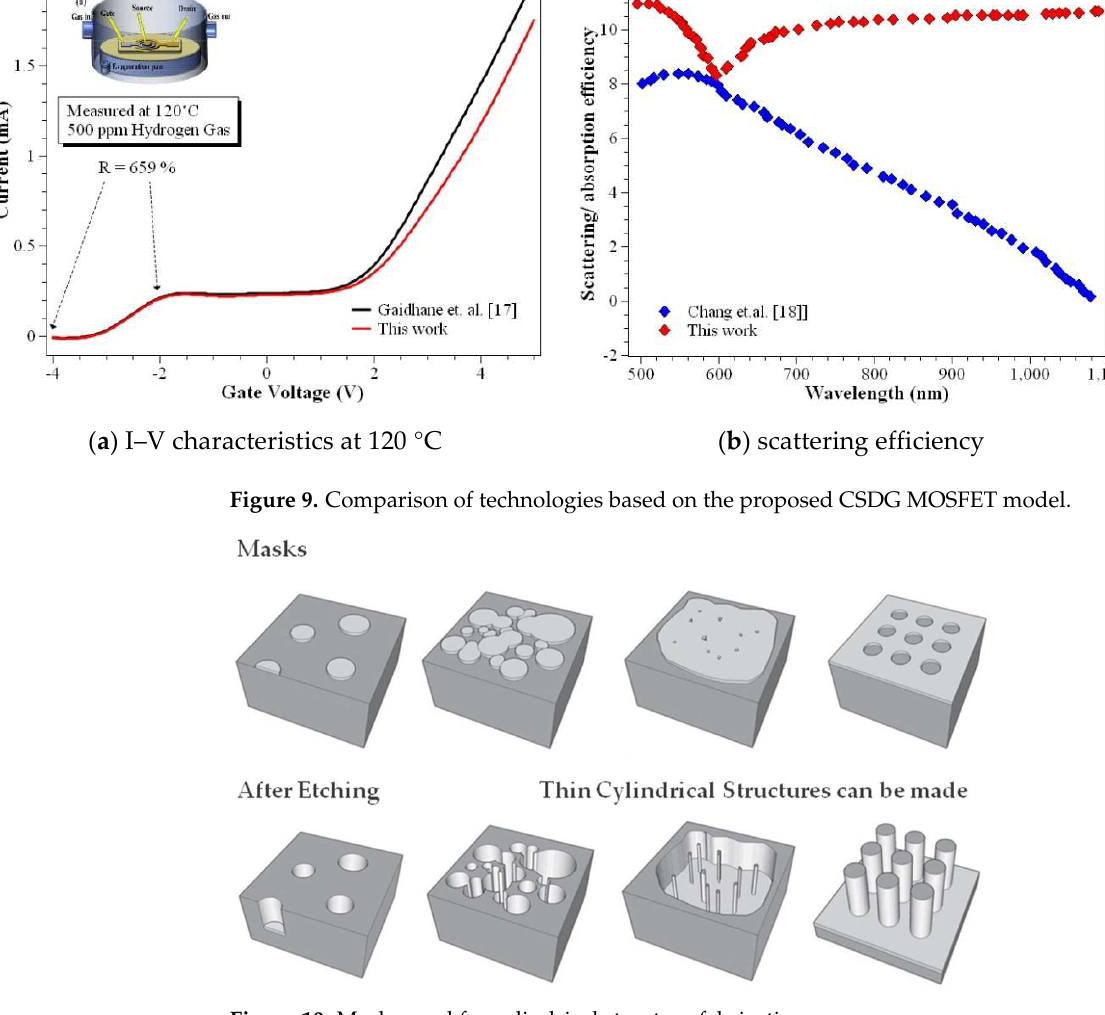
Figure 10. Masks used for cylindrical structure fabrication.